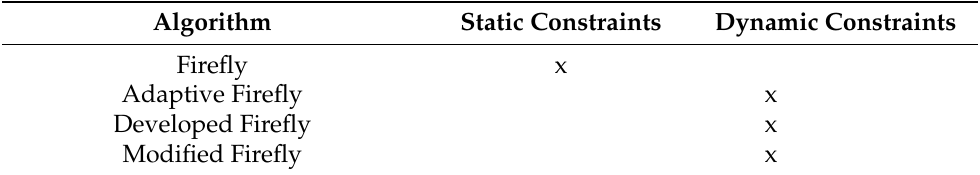
Table 7. Classification of the Firefly algorithm and its variants based on static and dynamic con-